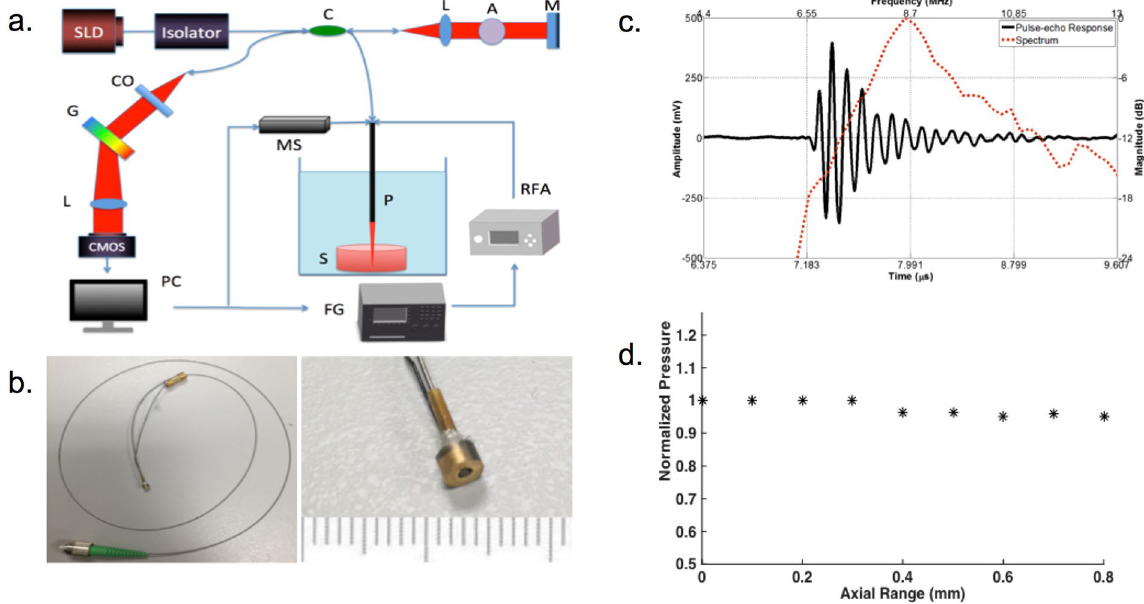
Figure 1. ( a ) Overview of ARFI OCE system set up. C: collimator, L: lens, A: attenuator, M: mirror, G: grating, MS: mechanical stage, RFA: radio frequency amplifier, P: probe, S: sample, FG: function generator. ( b ) Probe design (left). probe head including a ring transducer and optical elements inside (right). ( c ) Transducer frequency and echo characterization. ( d ) Transducer axial force field